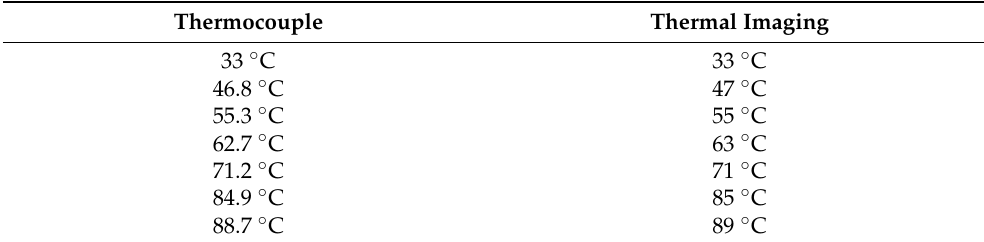
Table 3. Temperature comparison between thermocouple and thermal